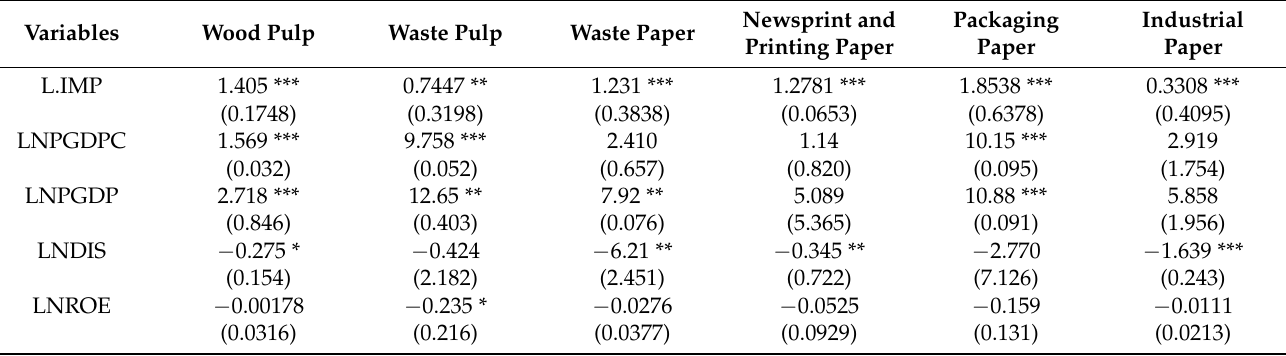
Table 6. Results of systematic GMM